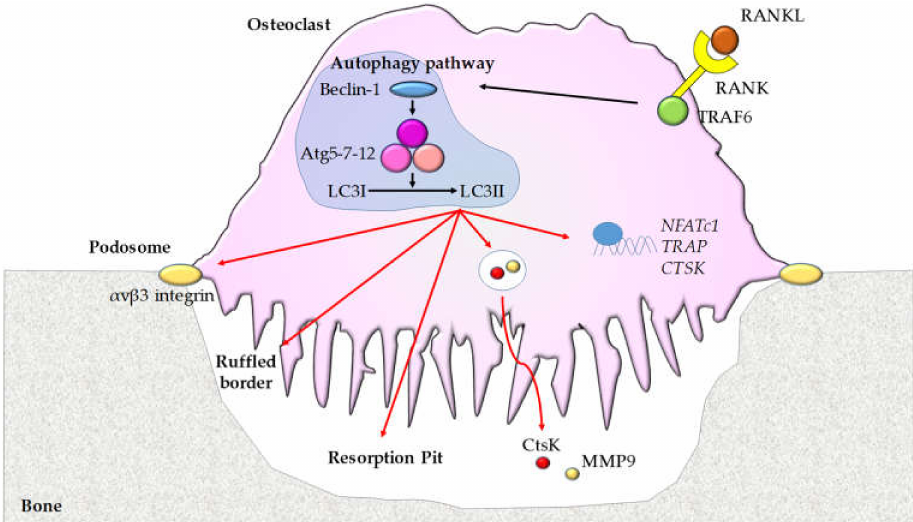
Figure 1. The role of autophagy in osteoclasts. Osteoblast-secreted and osteocyte-secreted RANKL that binds to its receptor RANK on osteoclasts leads to the recruitment of TRAF6 and an increase of Beclin-1 and Atg5 / 7 / 12 with enhanced conversion from LC3I to LC3II. This autophagic pathway regulates the expression of osteoclast genes [ NFATc1 , TRAP , and CTSK (Cathepsin K)], podosome and ru ffl ed border formation, and bone resorption activity stimulating the secretion of CtsK and